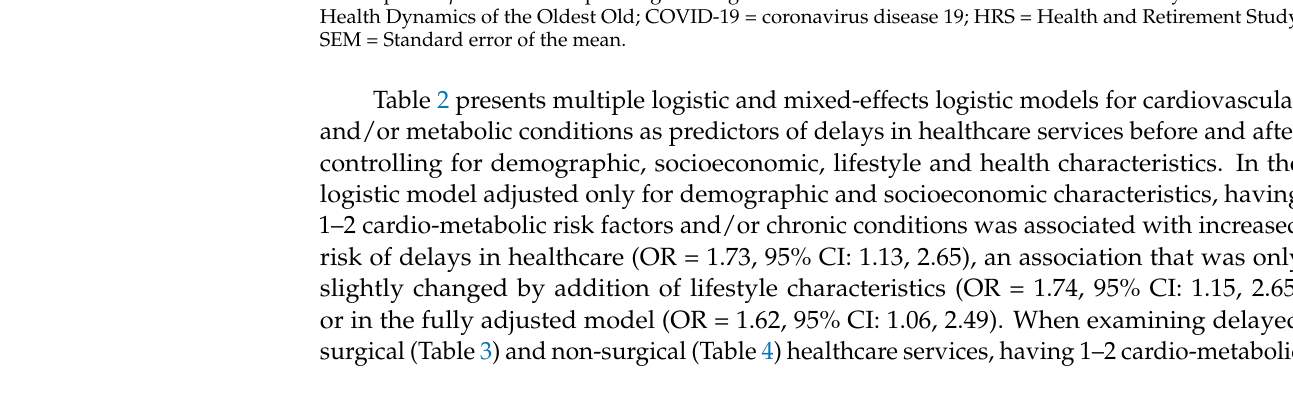
Table 2 presents multiple logistic and mixed-effects logistic models for cardiovascular and/or metabolic conditions as predictors of delays in healthcare services before and after controlling for demographic, socioeconomic, lifestyle and health characteristics. In the logistic model adjusted only for demographic and socioeconomic characteristics,